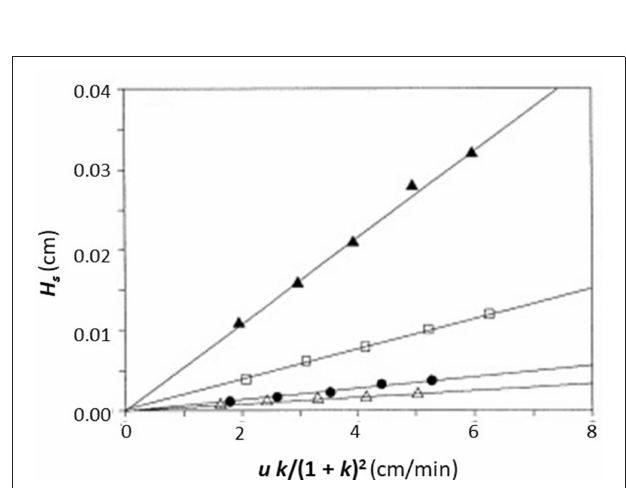
FIGURE 2 | General scheme for studying an analyte-binding agent interaction by using the plate height method. Terms: H total , total plate height; H s , plate height contribution due to stationary phase mass transfer; u , linear velocity of mobile phase; k , retention factor of the analyte; k d , dissociation rate constant.